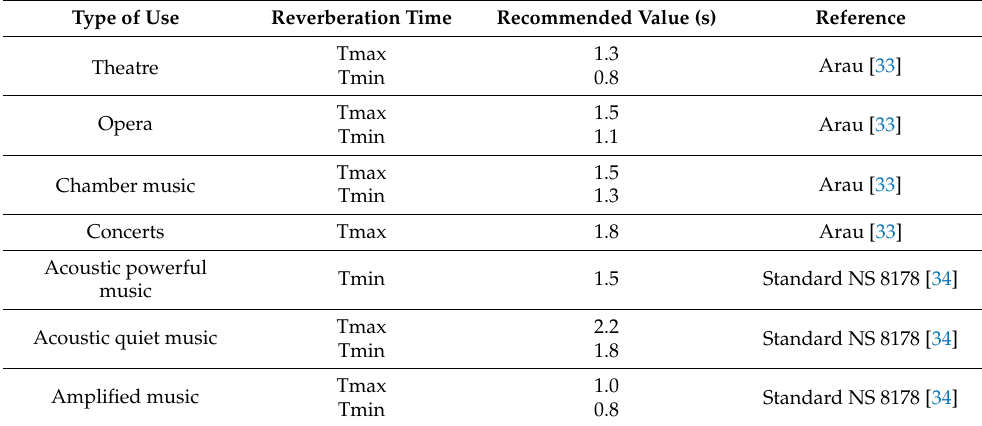
Table 4. Recommended reverberation times (mid-frequency octave bands: 500 Hz and 1000 Hz) suggested by Arau [33] and by standard NS 8178 [34], according to the type of use.